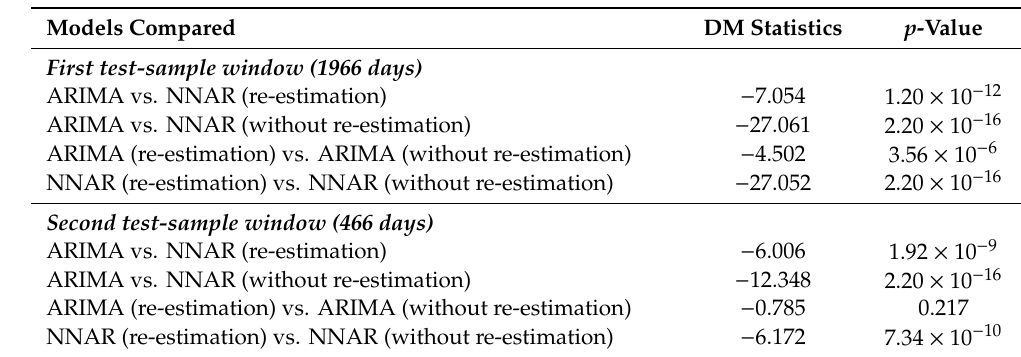
Table 4. DM test of forecast